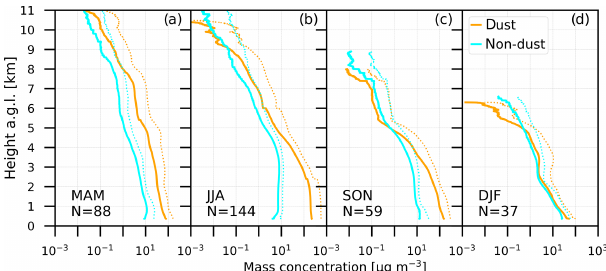
Figure 12. Seasonal mean dust (yellow) and non-dust (light blue) mass concentration profiles for (a) spring, (b) summer, (c) au- tumn, and (d) winter. The dotted lines show the (mean + SD) val- ues and provide an impression of the atmospheric variability. The (mean − SD) values are close to zero. Considered nighttime obser- vations N are given as